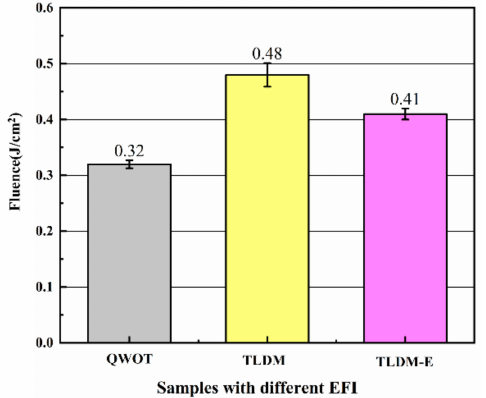
Figure 6. Damage threshold results for quarter-wave optical thickness (QWOT), CLDM, and E- CLDM. The thresholds of QWOT, CLDM and E-CLDM are 0.32, 0.48 and 0.41 J/cm 2 , respectively. EFI—electric field intensity; Fluence—radiant energy per unit